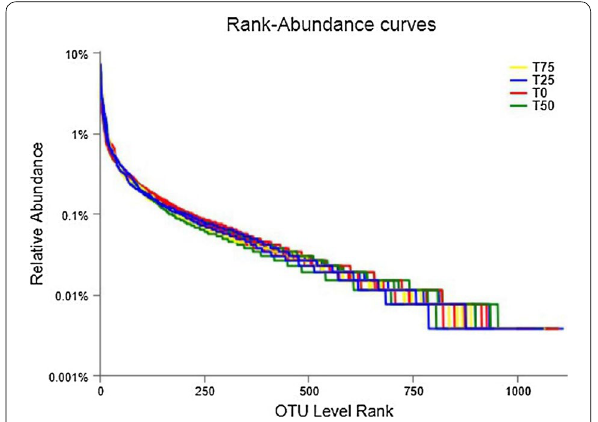
Fig. 4 Rank-abundance curves of feces samples